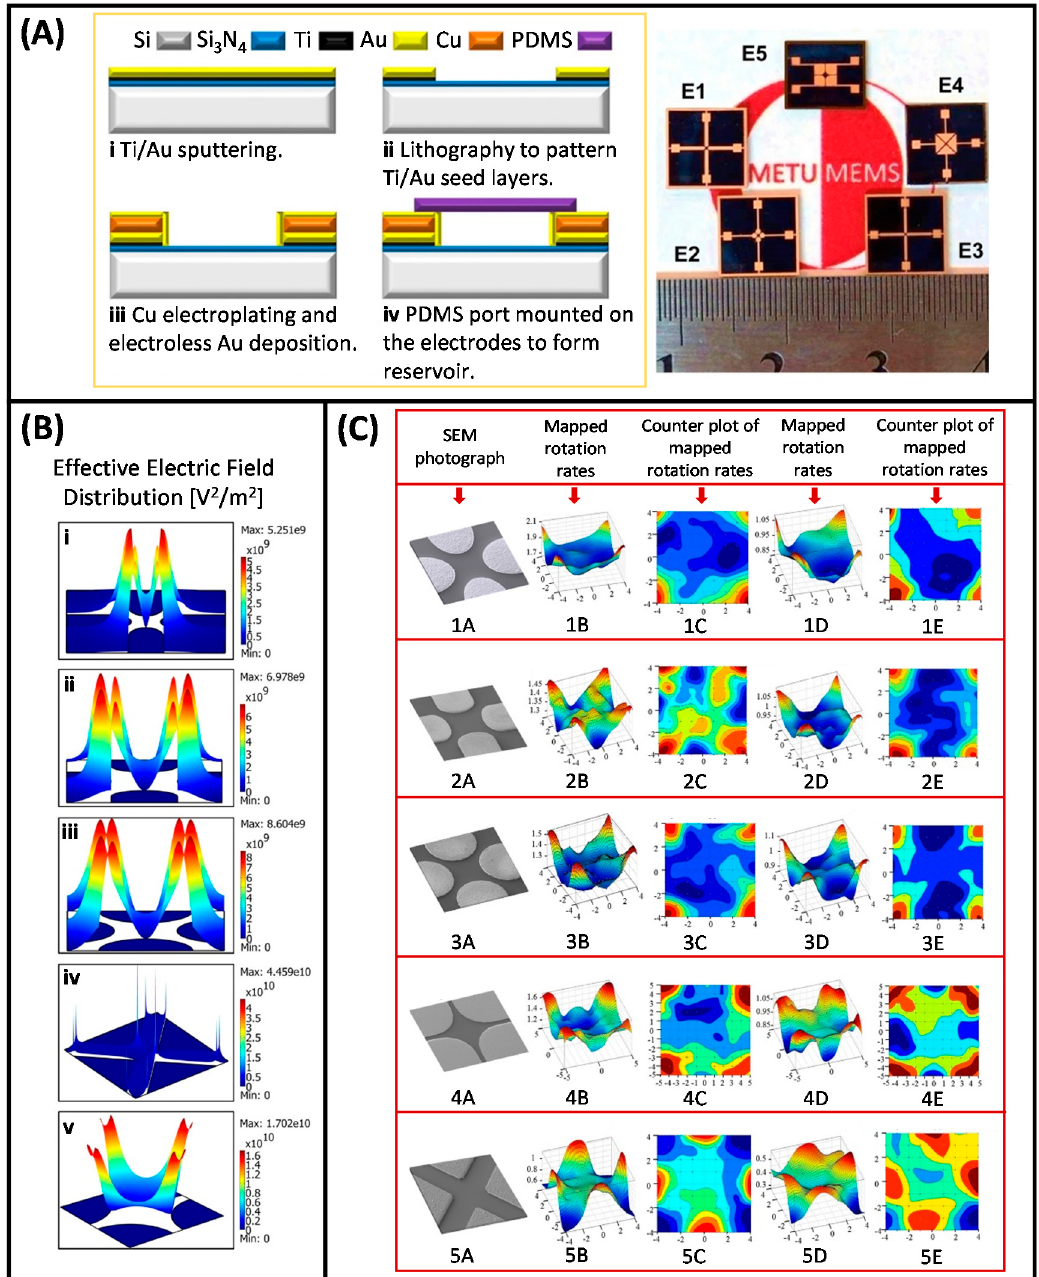
Figure 2. ( A ) Single mask fabrication process flow of the ER devices ( i ) Ti/Au sputtering, ( ii ) lithography, ( iii ) Cu electroplating, and ( iv ) mounting polydimethyl siloxane (PDMS) port, with the photograph of fabricated prototypes. (E1) Oblate elliptical, (E2) circular, (E3) prolate elliptical, (E4) triangular, and (E5) polynomial electrodes. ( B ) The height presentation of the EEF distributions for each electrode geometry, ( i ) prolate elliptical, ( ii ) oblate elliptical, ( iii ) circular, ( iv ) polynomial, and ( v ) triangular electrodes. ( C ) The extracted rotational torque maps together with SEM images of the ER devices with prolate elliptical ( 1A – E ), oblate elliptical ( 2A – E ), circular ( 3A – E ), polynomial ( 4A – E ), and triangular ( 5A – E ) electrodes [162]. Copyright 2015, John Wiley and